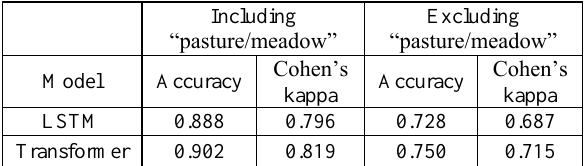
Table 3. Overall accuracy and Cohen’s kappa obtained on the testing subset using an LSTM and a Transformer model, both including and excluding the crop class “pasture/meadow” from scores computation. The transformer classifier performs better, with scores overall 2- 3% higher than LSTM. This is generally true also for class- specific scores (Figure